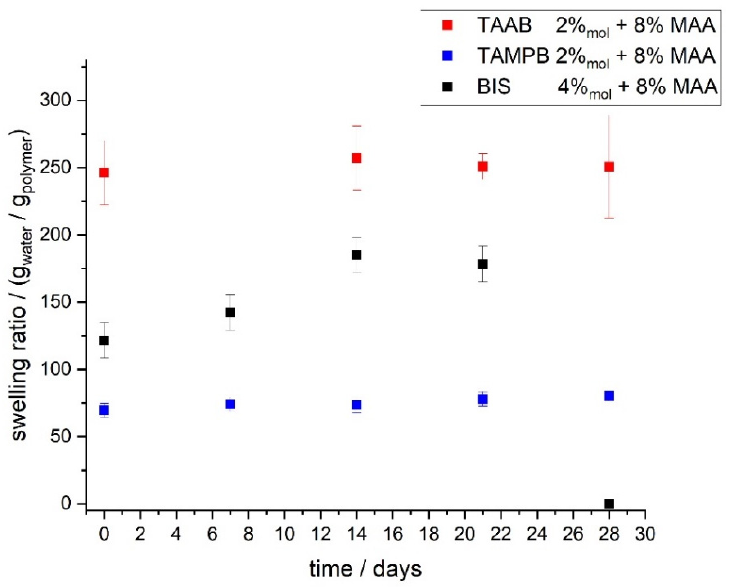
Figure 8. Equilibrium degree of swelling of poly(DADMAOH- co -MAA) hydrogels crosslinked with 2 mol% TAAB/2 mol% TAMPB/4 mol% BIS at different times after storage of the polymerized gels at 60 °C. All gels were lyophilized before the swelling tests.